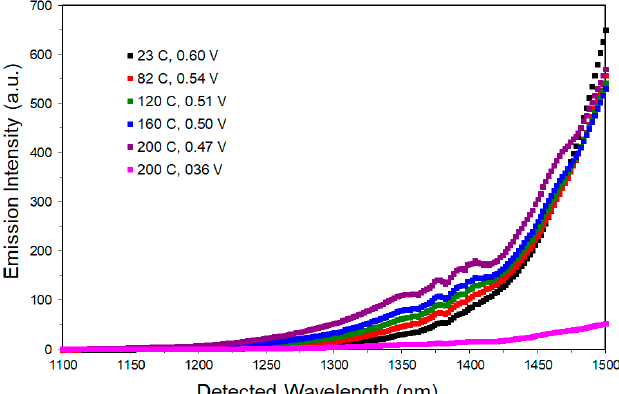
Figure 5. Intensity vs Wavelength at Various Temperatures and Bias Voltages. Voltages were chosen to produce the same intensity value at 1500 nm.